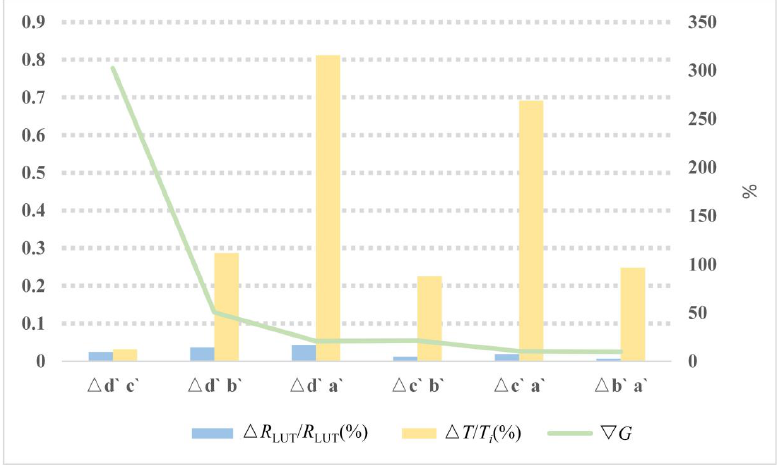
Figure 9. ∇ G of schemes in interferogram generation with different threads.